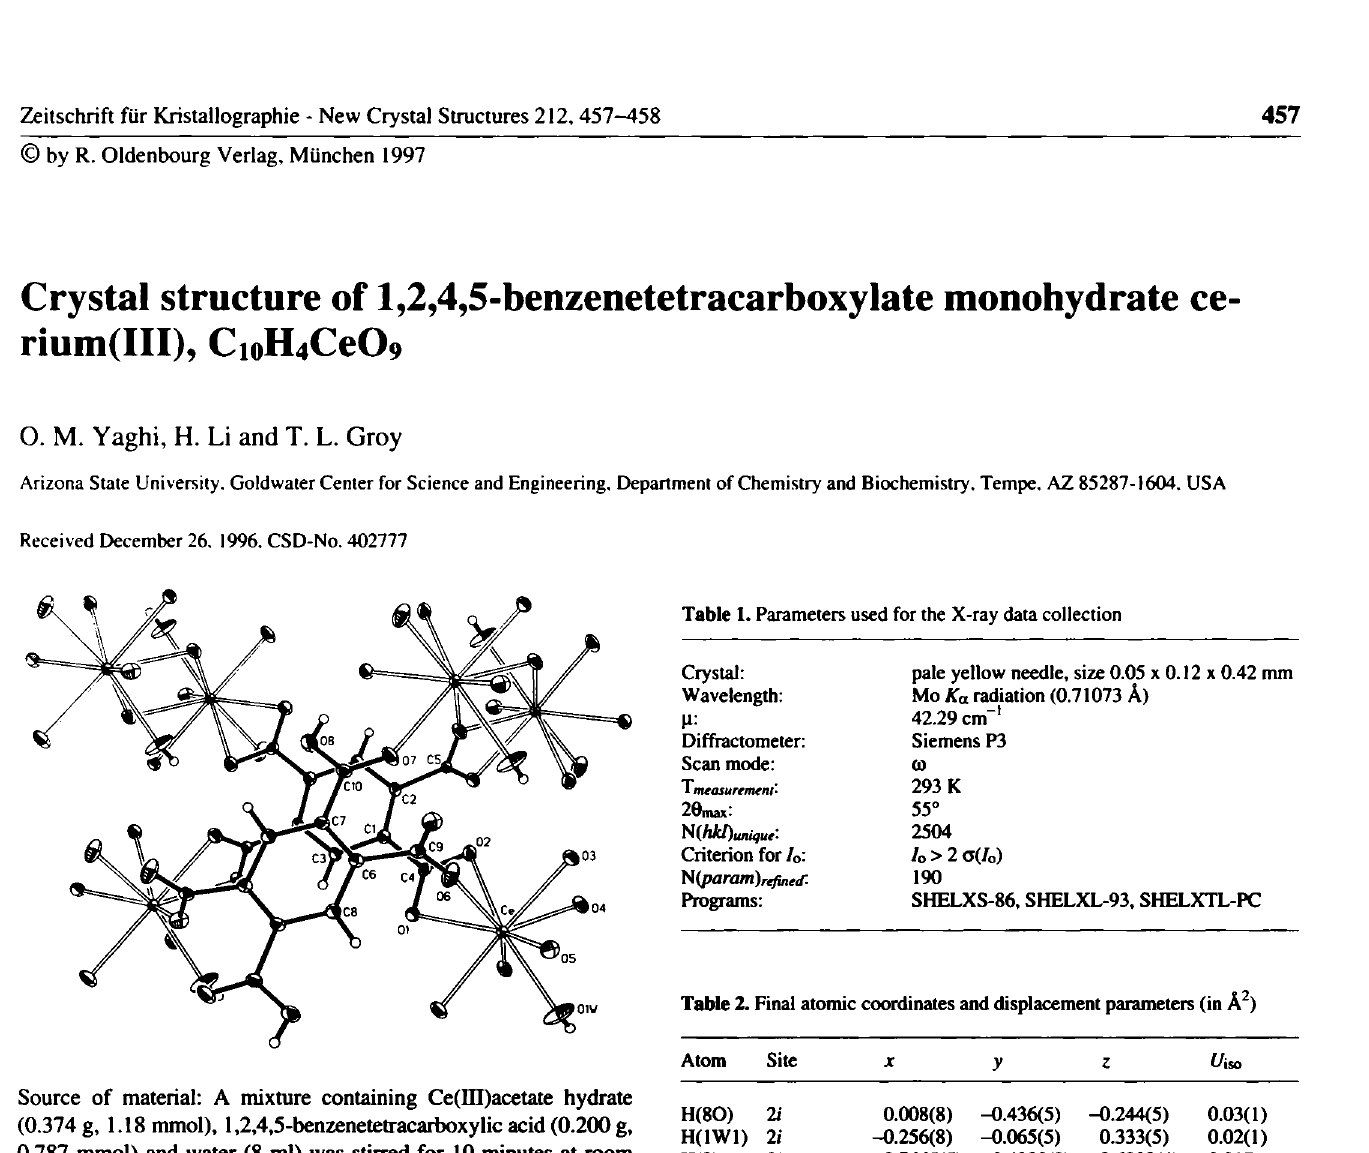
Table 3. Final atomic coordinates and displacement parameters (in Â 2 )